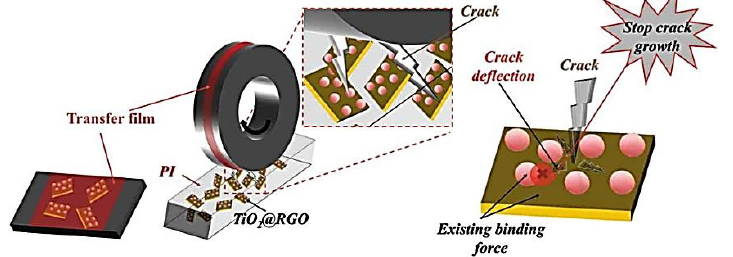
Figure 14. The friction mechanism of the ‘PI + TiO2@RGO’ composites. Figure is reproduced with permission from reference [91].